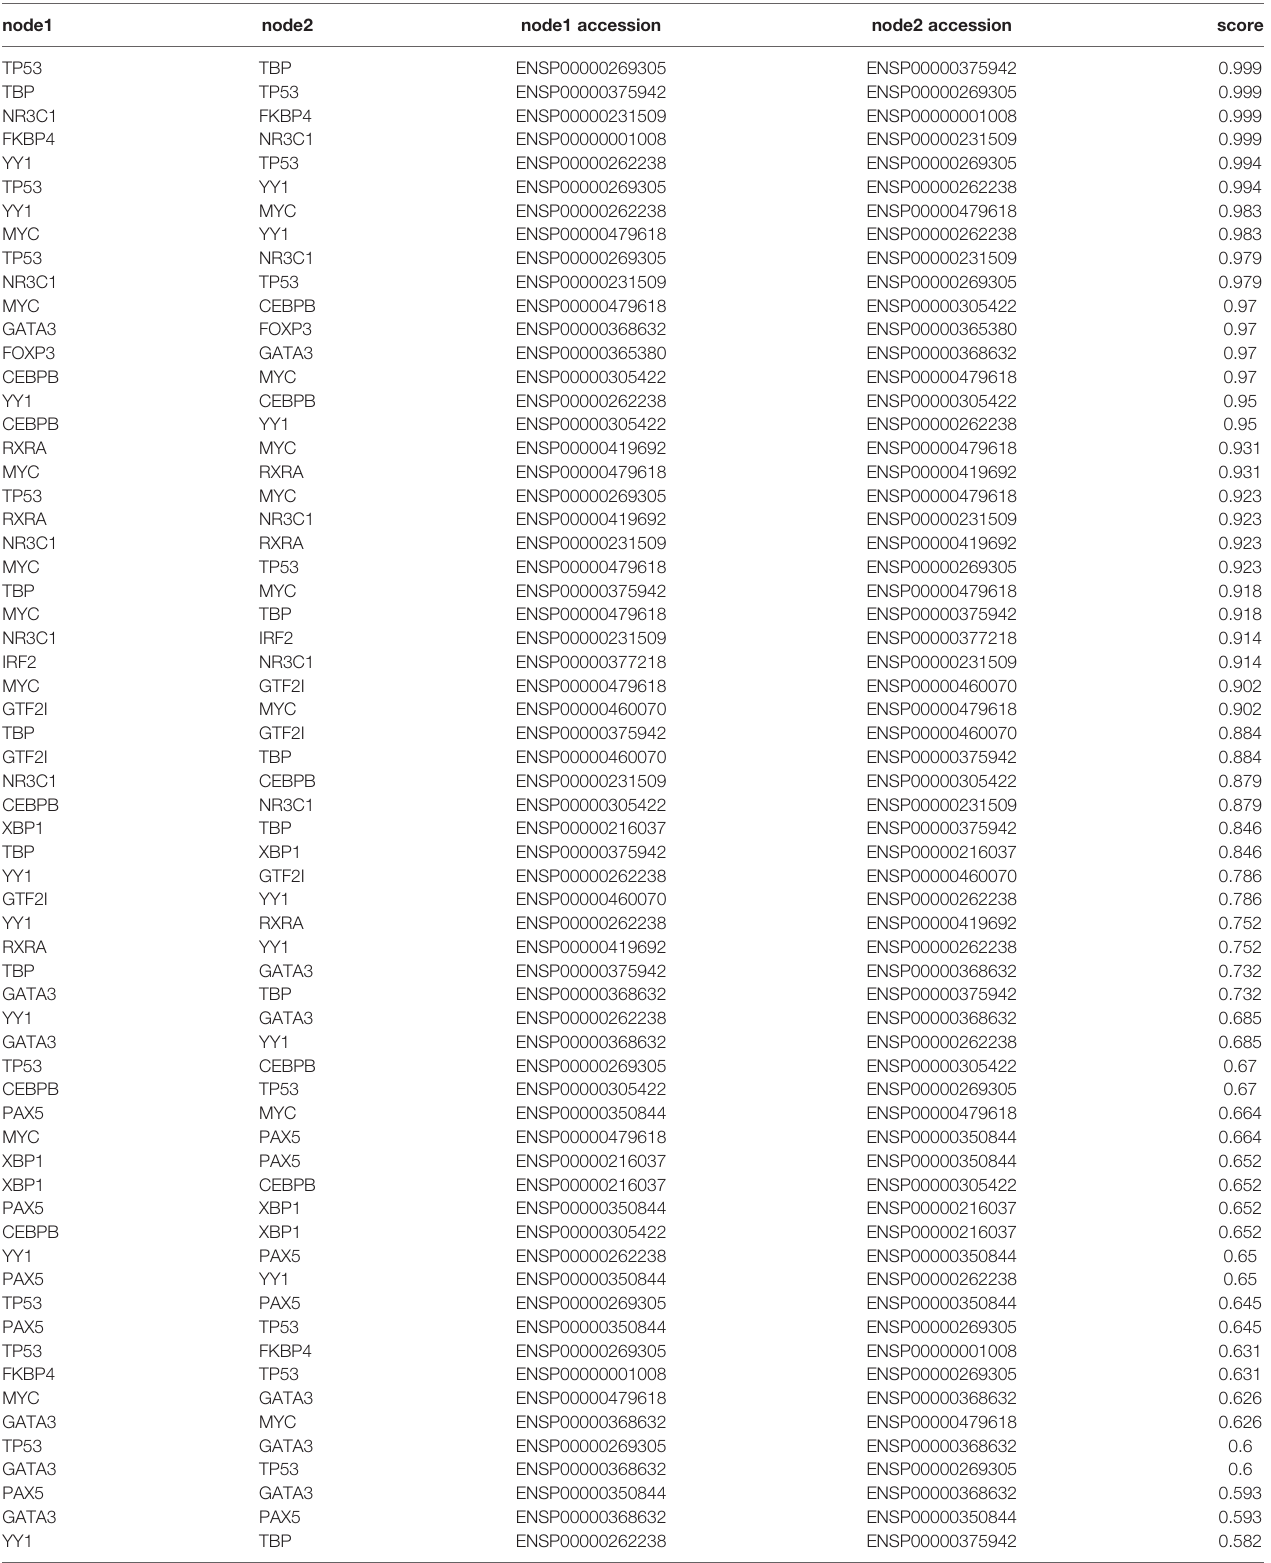
TABLE 2 | Protein to protein interacting score of FKBP4 and predicted NRF2 transcription